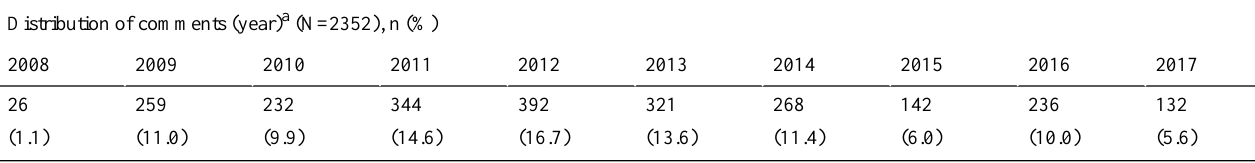
Table 1. Distribution of rejected feedback according to year. Distribution of comments (year) a (N=2352), n